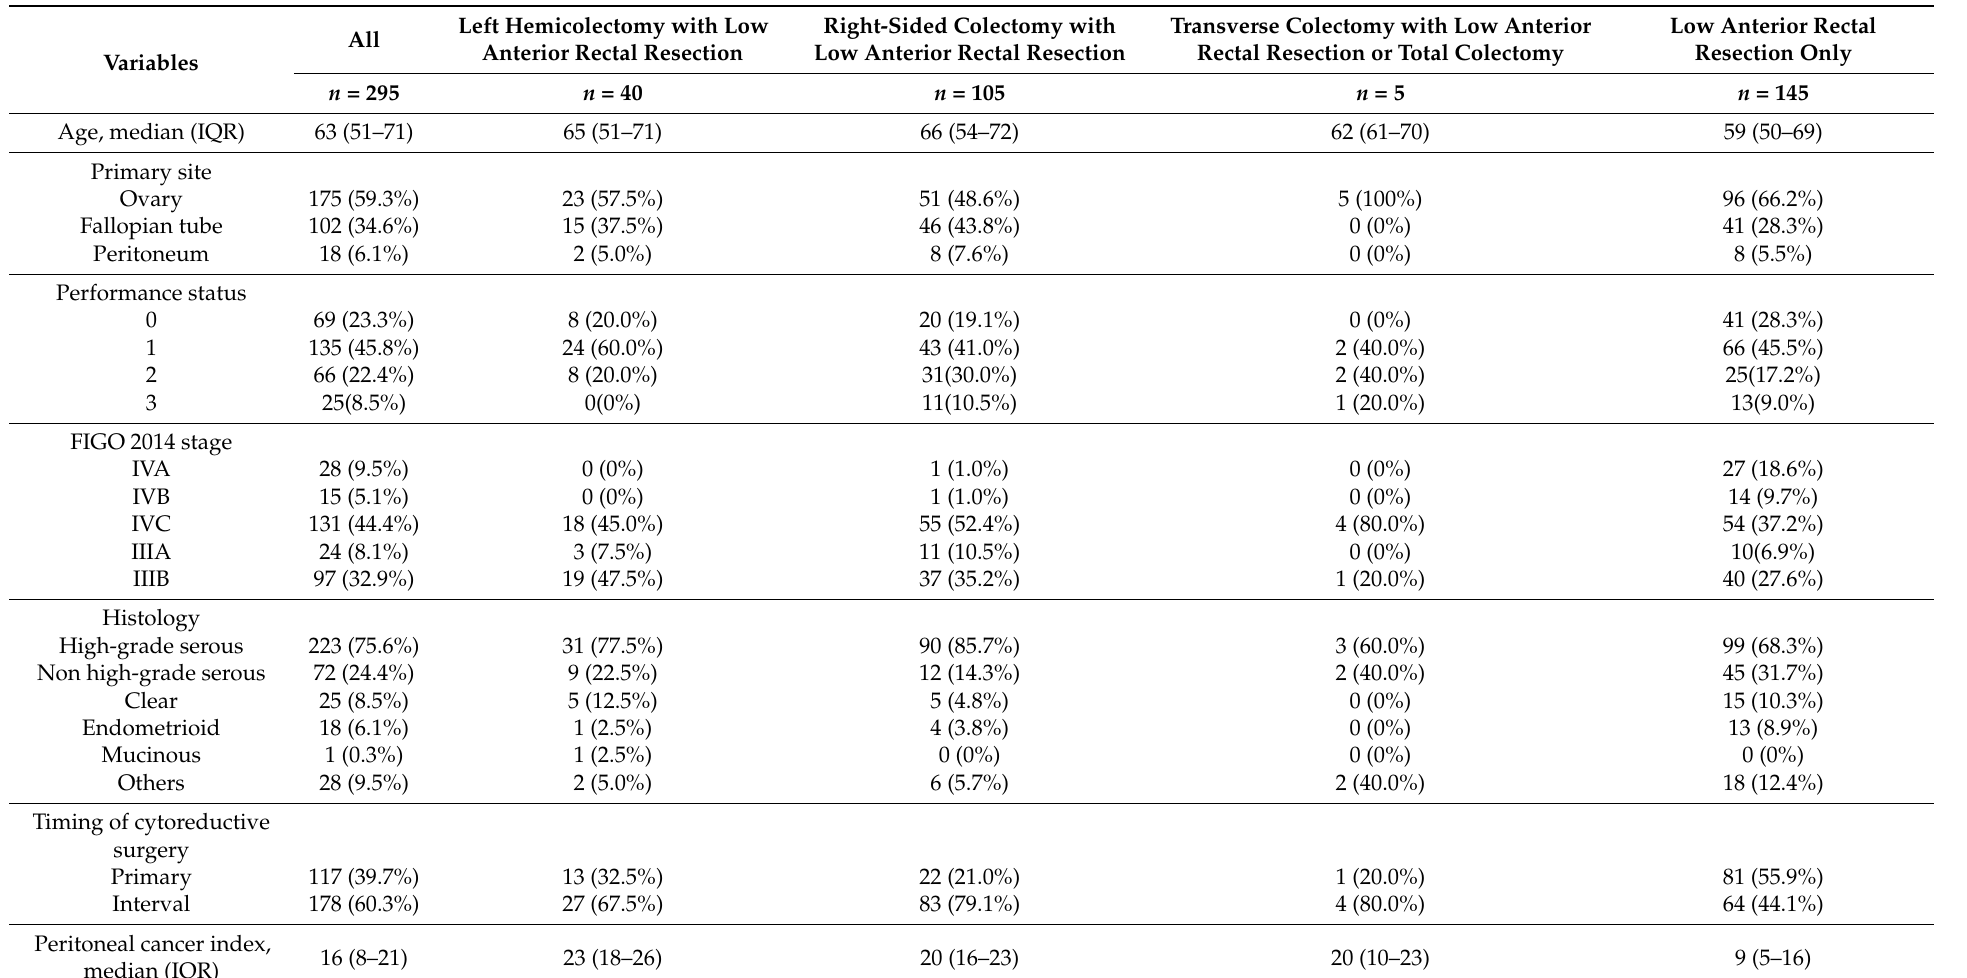
Table 1. Patients characteristics.